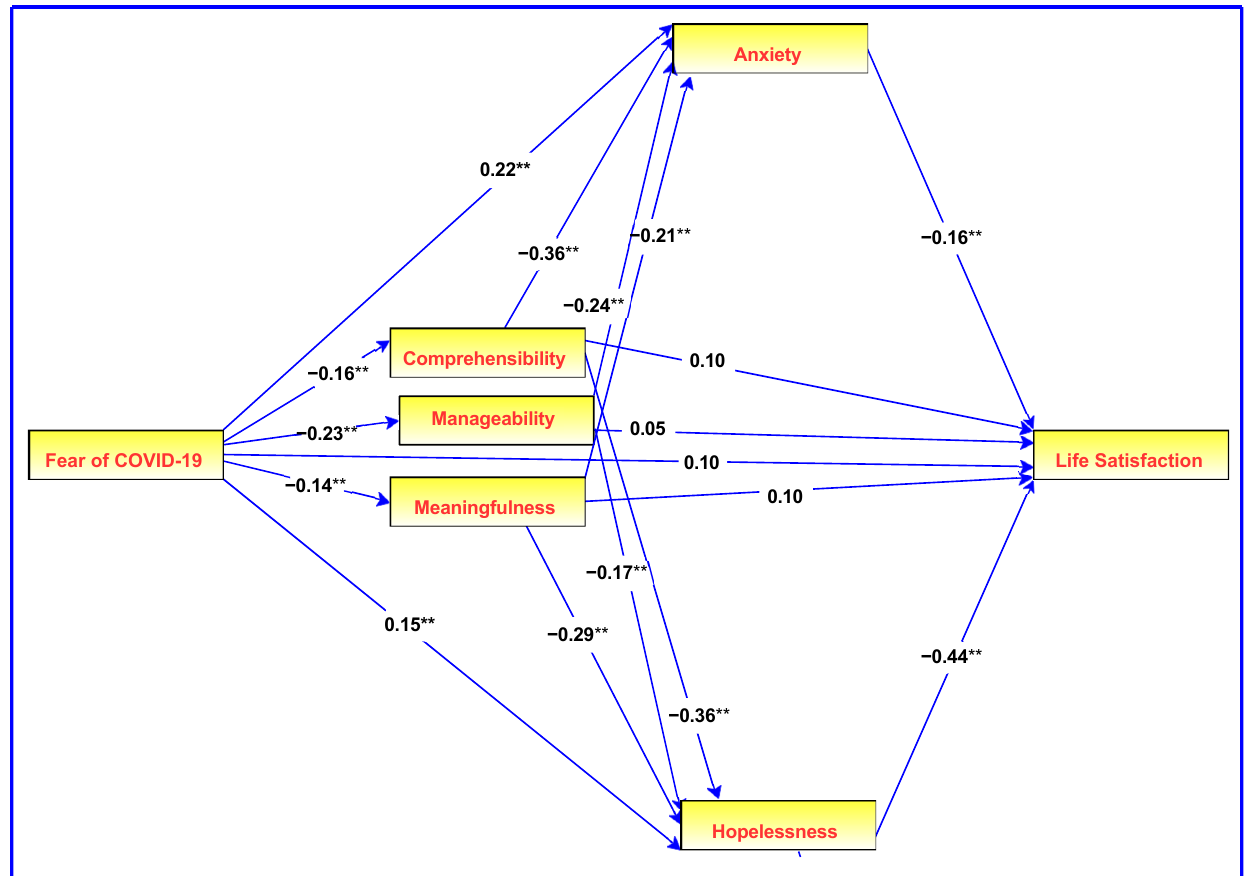
Figure 1. Serial model of the relationships among the fear of COVID-19, the sense of coherence, hopelessness, anxiety, and life satisfaction. Regression coefficients are standardized. ** p < 0.01.